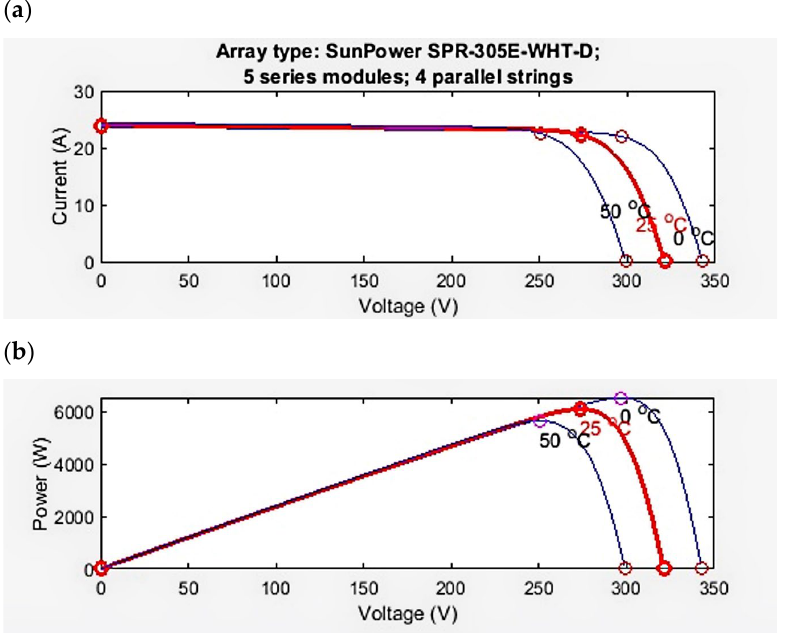
Figure 15. Curves showing the relationship between current ( a ) and power ( b ) and voltage, depend- ing on irradiance and cell temperature, generated in Matlab/Simulink.